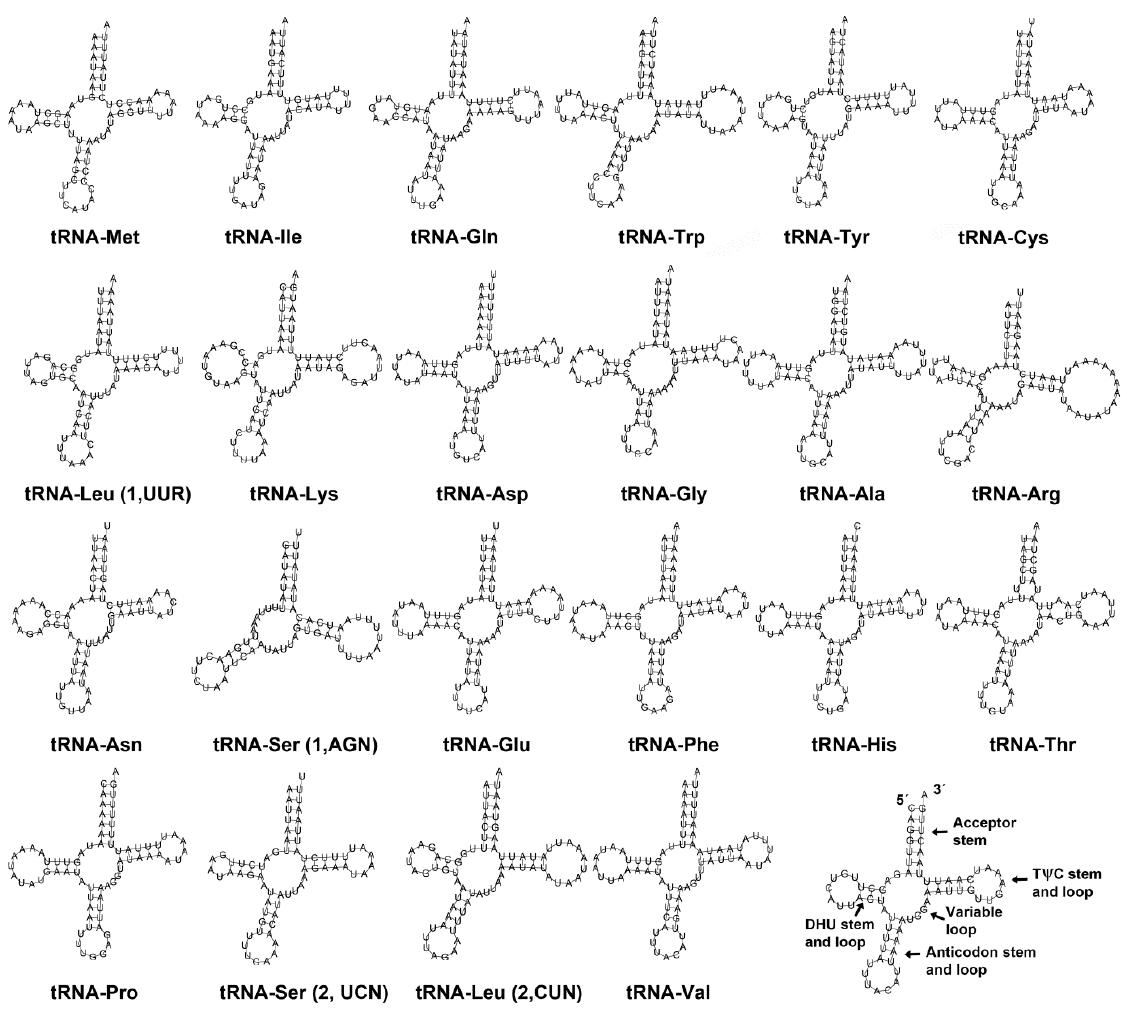
Figure 3. Secondary estructures of all